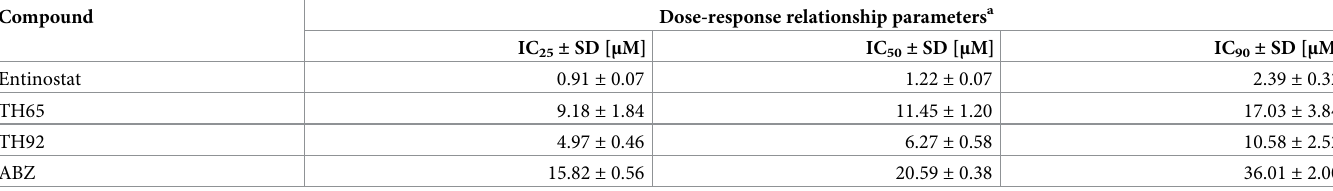
a The reported values were calculated from three independent biological replicates, each one in quadruplicate, and were expressed with their respective standard deviations (SD).